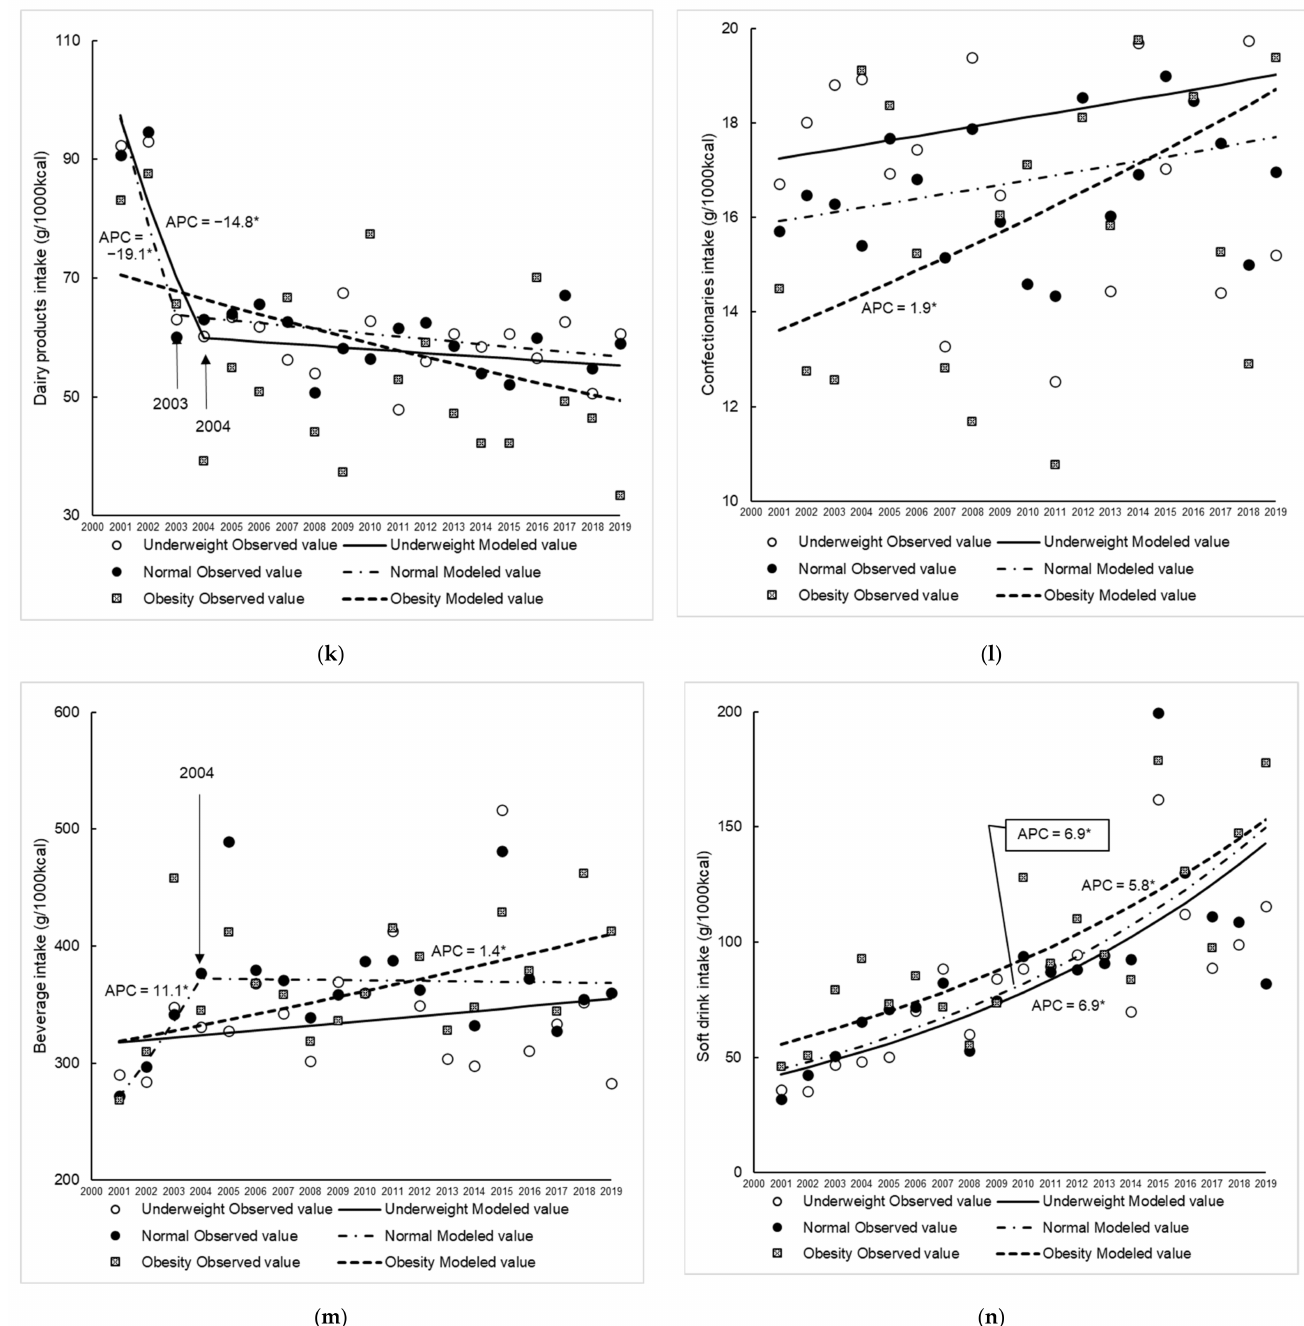
Figure 3. Trends in food group intake among young women classified as underweight, normal and obese between 2001 and 2019. Grains ( a ), rice ( b ), potatoes ( c ), vegetables ( d ), mushrooms ( e ), fruits ( f ), fresh fruits ( g ), seaweed ( h ), fish and shellfish ( i ), meat ( j ), dairy ( k ), confectionaries ( l ), beverages ( m ), soft drinks ( n ). Trends in food group intake were analysed using Joinpoint regression analysis ( p < 0.05). APC, annual percentage change. * p <